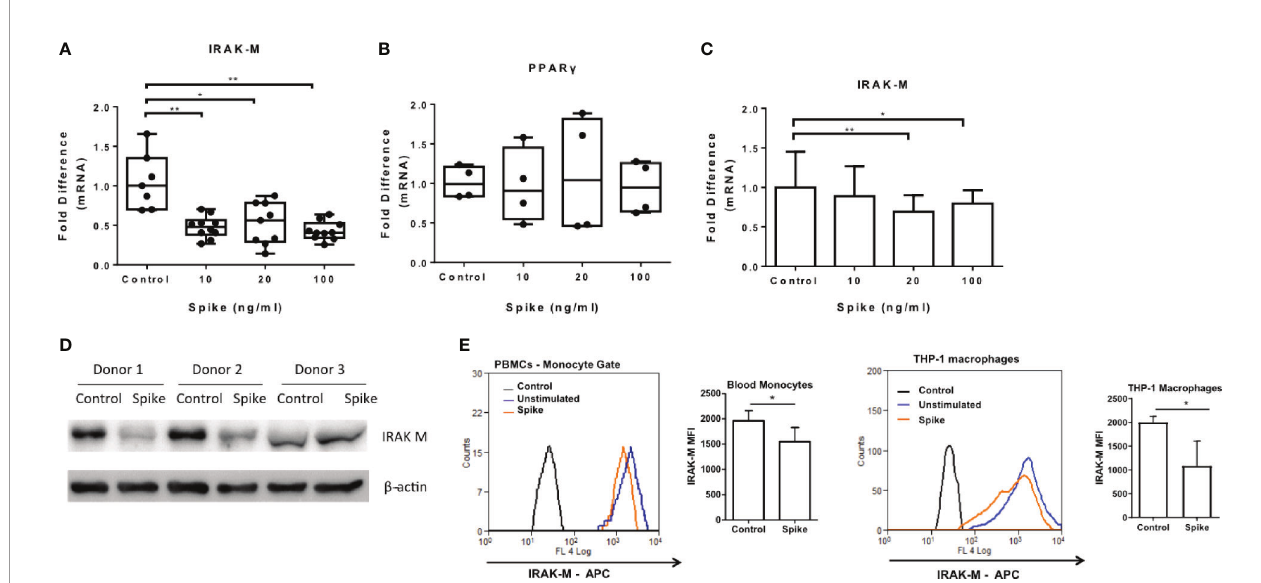
FIGURE 7 | SARS-CoV-2 S protein suppressed IRAK-M expression. THP-1 macrophages, PBMCs and monocytes were treated with different concentrations of SARS-CoV-2 S protein for 12 hours. (A) Decreased IRAK-M expression was observed in THP-1 macrophages. (B) No effect observed for PPAR g in THP-1 macrophages. (C) Decreased IRAK-M expression in PBMCs and CD14+ monocytes respectively was observed. (D) Decreased IRAK-M protein levels in western blot from PBMCs of three healthy donors in the presence of SARS-CoV-2 S protein. (E) Decreased IRAK-M protein levels in PBMCS and THP-1 macrophages in fl ow cytometry. Data are illustrated in box-and-whiskers, plotted as median (± min, max) and statistical analysis was performed with Kruskal - Wallis test, regarding THP-1 macrophages (A, B) . For PBMCs data are illustrated in bars and plotted as mean ± SD (C) . Statistical analysis was performed with One-Way ANOVA test (C) . *p < 0.05, **p <